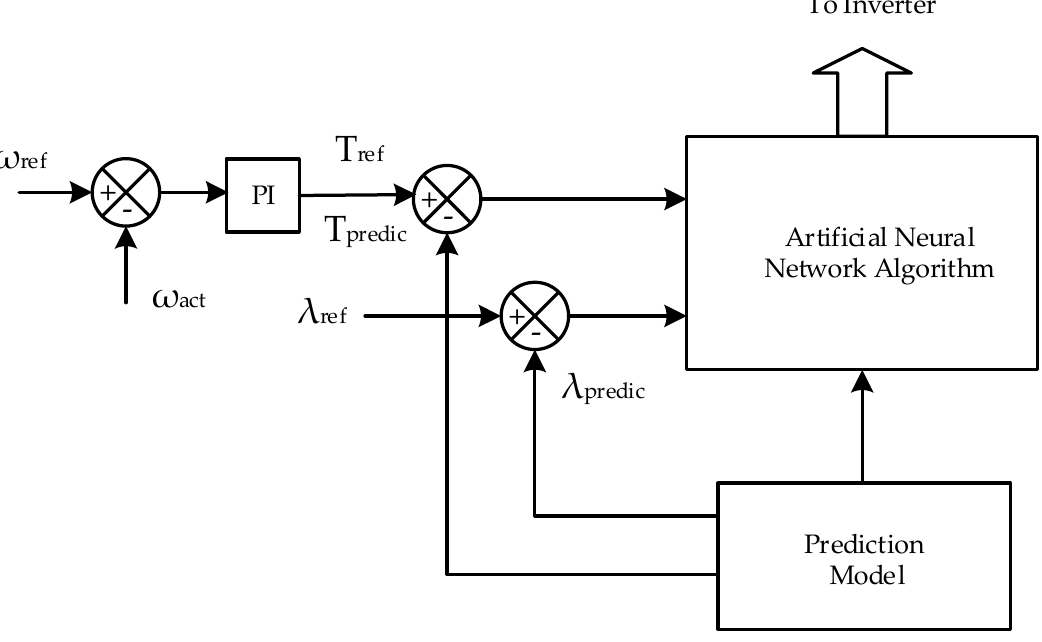
Figure 5. Intelligent control of BLDC motor.